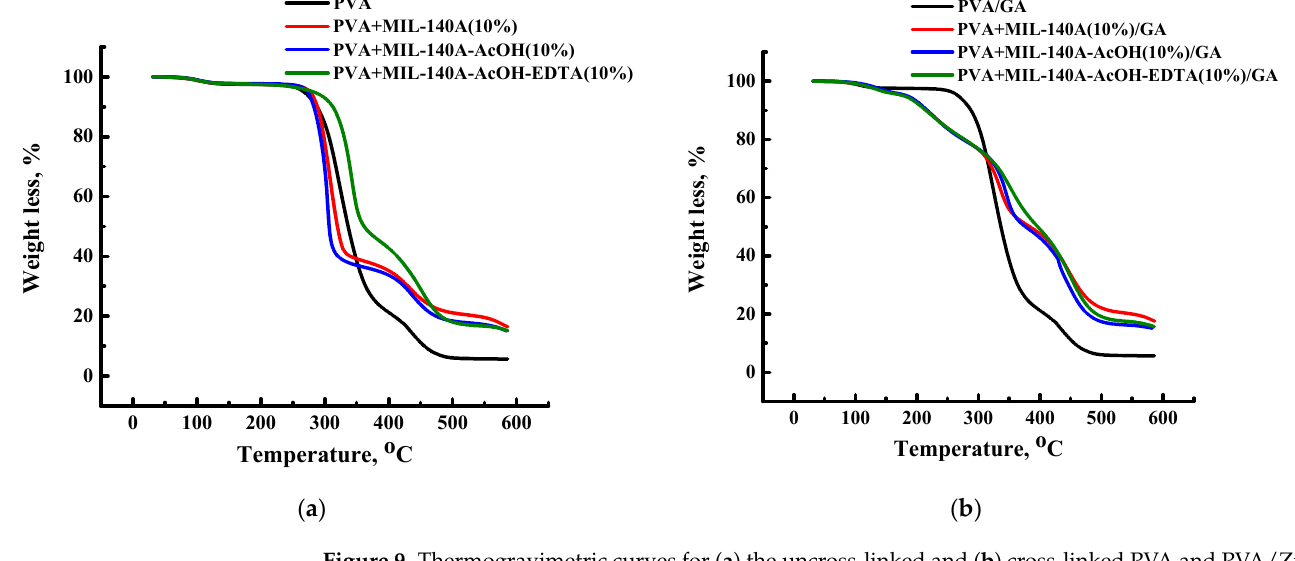
Figure 9. Thermogravimetric curves for ( a ) the uncross-linked and ( b ) cross-linked PVA and PVA/Zr-MOFs(10%) membranes. MOFs(10%)